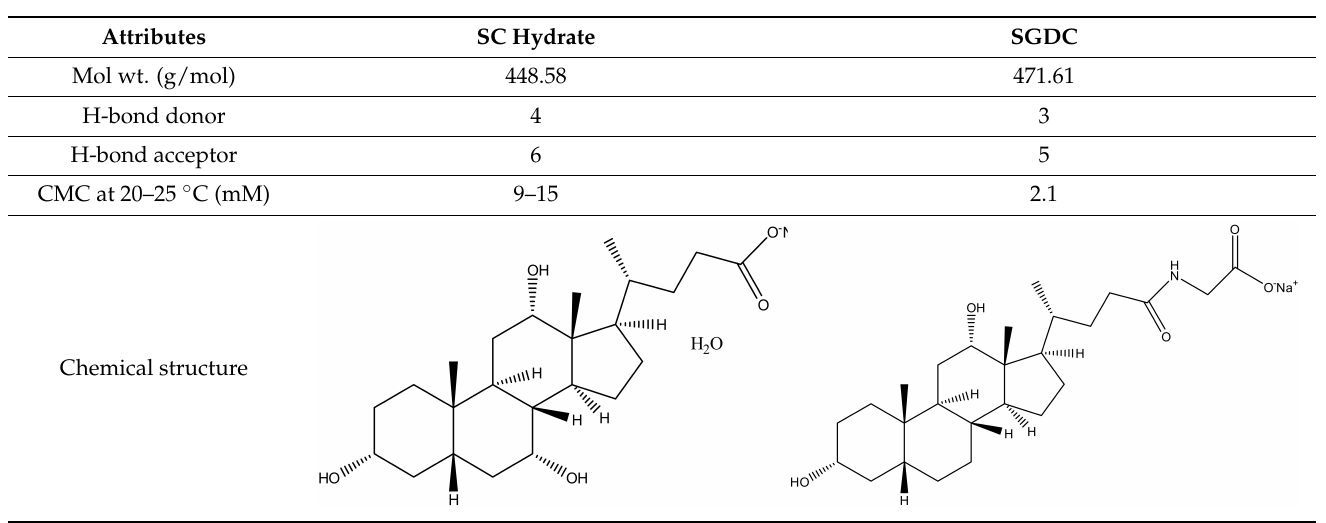
Table 1. Comparison of physical and chemical attributes of trihydroxy (SC) and dihydroxy (SGDC) bile salts. Mol wt., molecular weight; CMC, critical micelle